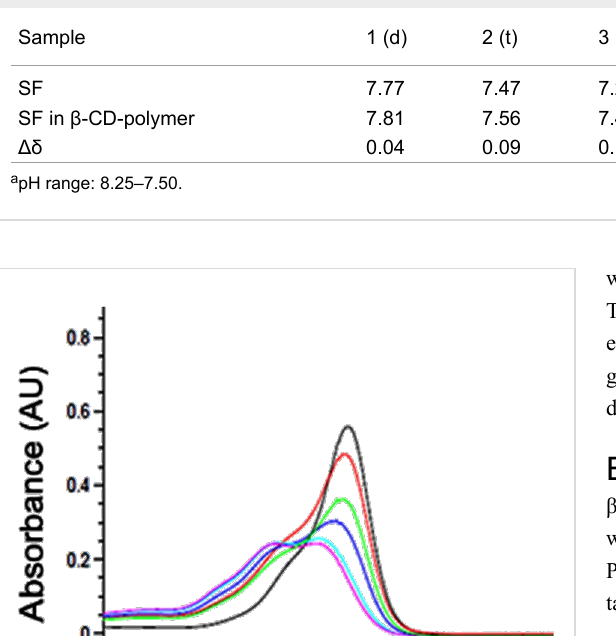
Table 1: 1 H NMR chemical shifts (ppm) of sodium fluorescein (SF) in D 2 O solution without and with branched β -CD polymer. The numbers refer to SF atom numbering, symbols in parentheses indicate signal multiplicity. a Sample